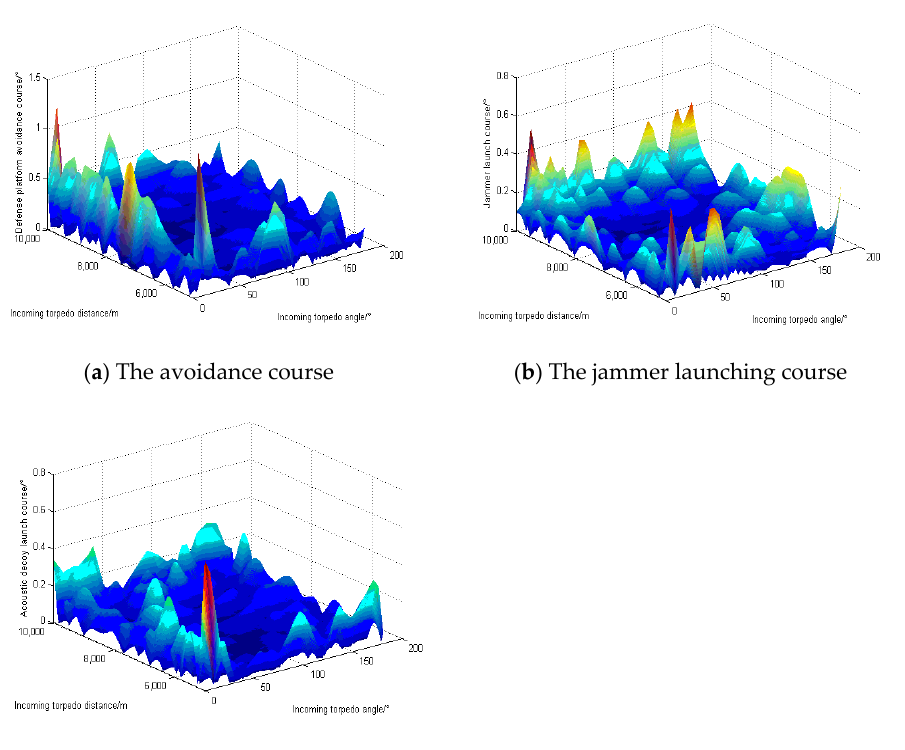
Figure 16. The difference between the optimized GA-BP neural network’s test output and the actual output.